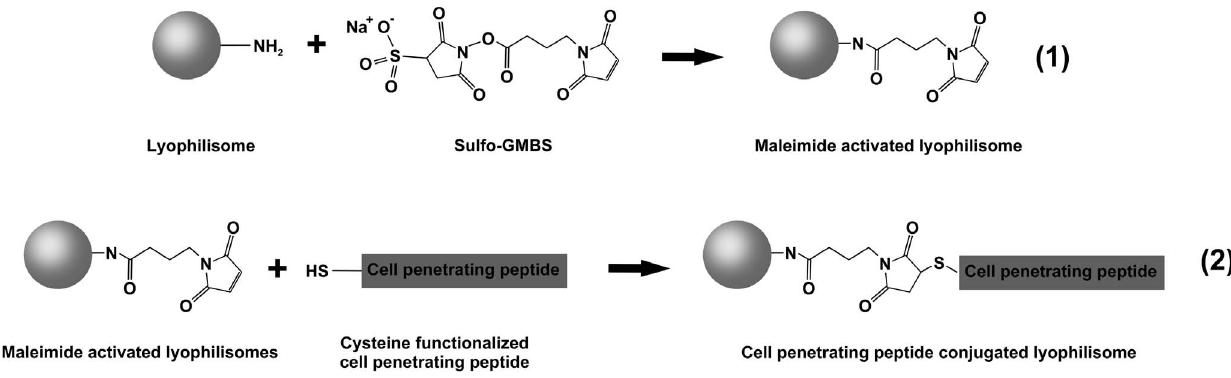
Figure 1. Schematic illustration of the conjugation of the cell-penetrating peptide (CPP) TAT to lyophilisomes. (1) Primary amine groups of lyophilisomes react with Sulfo-GMBS introducing reactive maleimide groups. (2) CPPs (cysteine-functionalized TAT-peptides; C-Ahx- YGRKKRRQRRR) are conjugated to maleimide-conjugated lyophilisomes, resulting in stable CPP-conjugated lyophilisomes. Sulfo-GMBS = sulfo- N -[ c - maleimidobutyryloxy]sulfo succinimide ester; Ahx = aminohexanoic acid; TAT = trans-activating transcriptional activator.